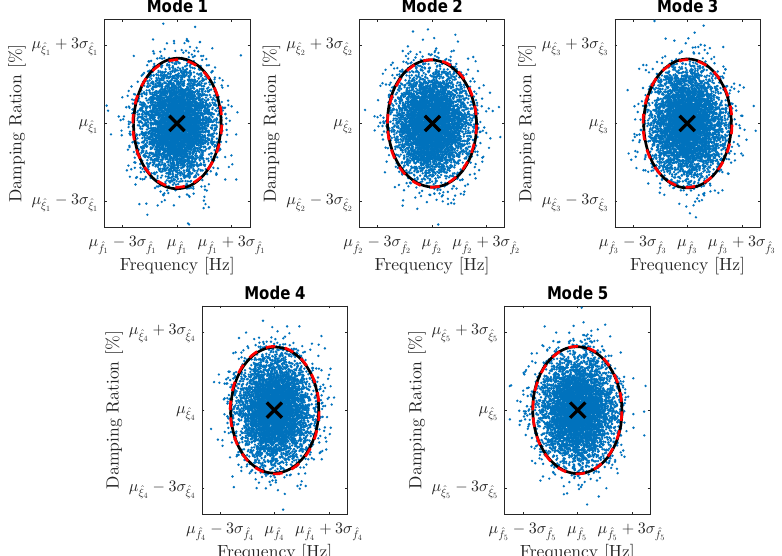
Figure 8. Covariances on the estimates for the natural frequencies and damping ratios obtained with the MLE-PMM for all modes of the 5-DOF system: estimates obtained after 10 iterations of the MLE-PMM over the Monte Carlo realizations (blue dots); 95% elliptical confidence regions obtained from the sample covariance, Cov ( ˆ f n , ˆ ξ n ) (continuous black line); and 95% elliptical confidence regions obtained from the mean over the covariance estimates provided by the MLE-PMM over the Monte Carlo simulations (dashed red